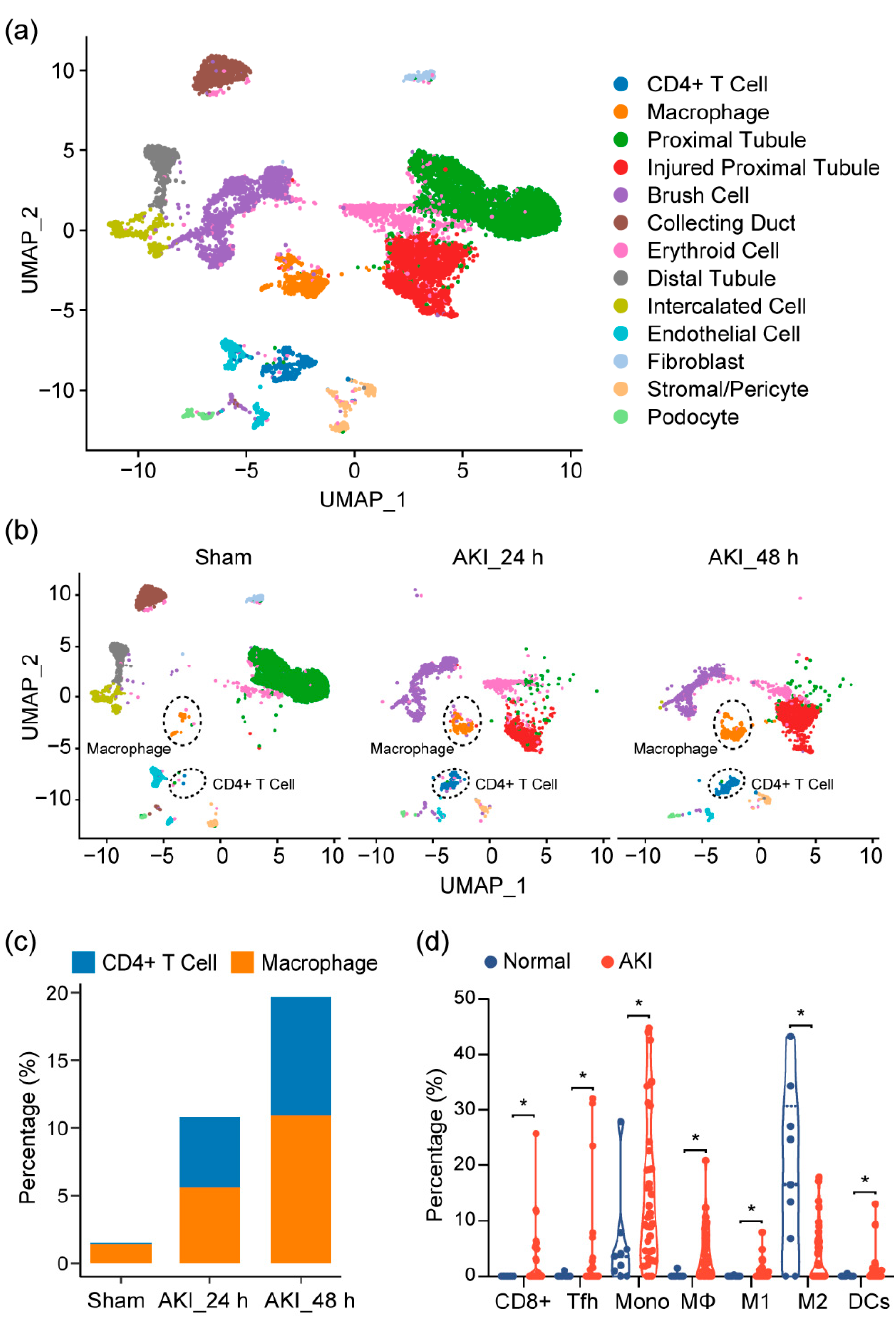
Figure 3. Immune characterization and profiles of AKI. ( a ) UMAP clustering of cell types in kidneys, from normal and AKI mice, by analysis of single-cell RNA-sequencing data (GSE139506). ( b ) Cell- type distribution in kidneys, from normal and AKI mice, 24 h and 48 h after induction of AKI. ( c ) Quantification of CD4+ T cells and macrophage cells, as percentage of total cell populations, in kidneys from normal and AKI mice. ( d ) Estimated proportion of the immune subpopulations in human kidney biopsy samples (GSE139061) using CIBERSORT analysis. Data are presented as mean ± SEM. AKI ( n = 39) and normal ( n = 9), * p < 0.05.